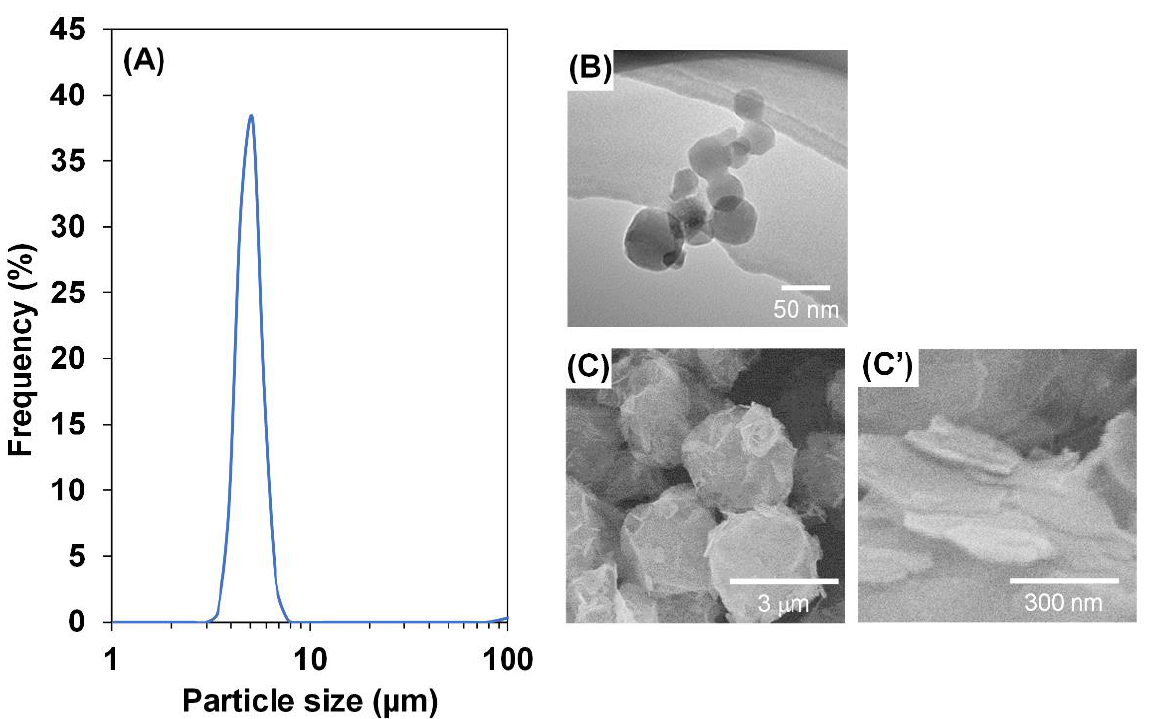
Figure 1. Characterization of S-MgO(H 2 O) particles. ( A ) Particle size distribution, ( B ) TEM image of the raw MgO nanoparticles (MgO50), ( C ) SEM image, and ( C’ ) its high magnification.